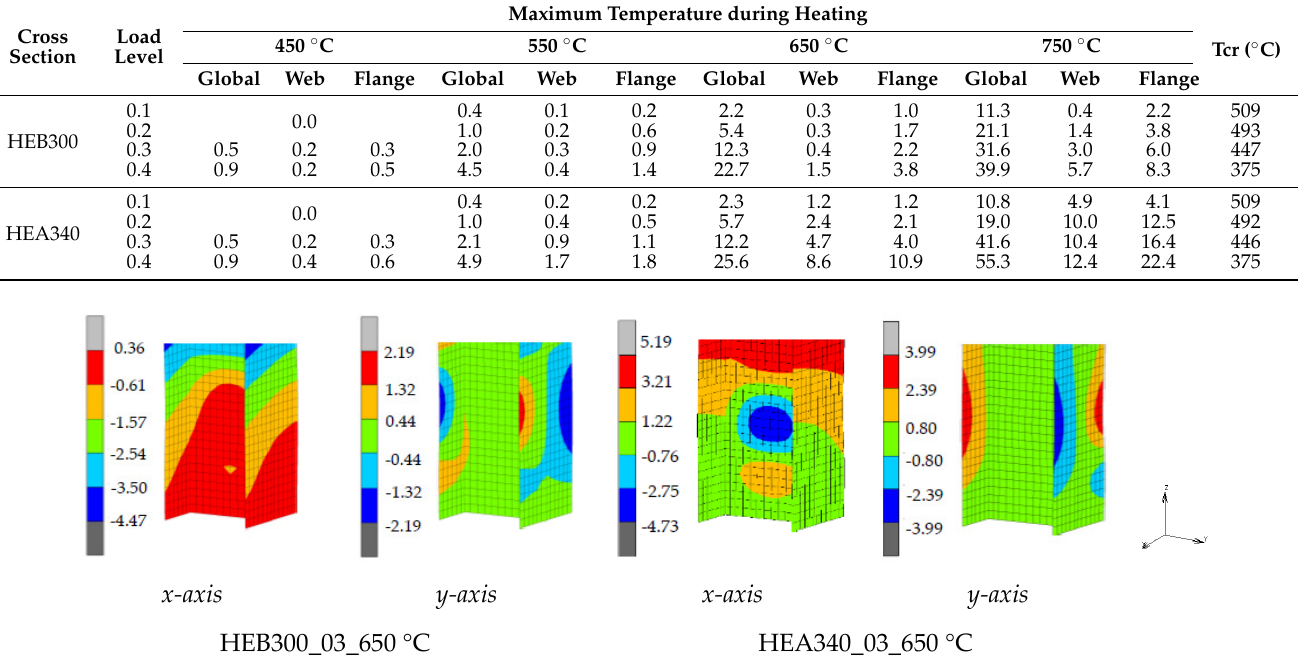
Figure 9. Displacement field at the end of the cooling stage, near the base of the HEB300_03_650 °C and HEA340_03_650 °C columns.